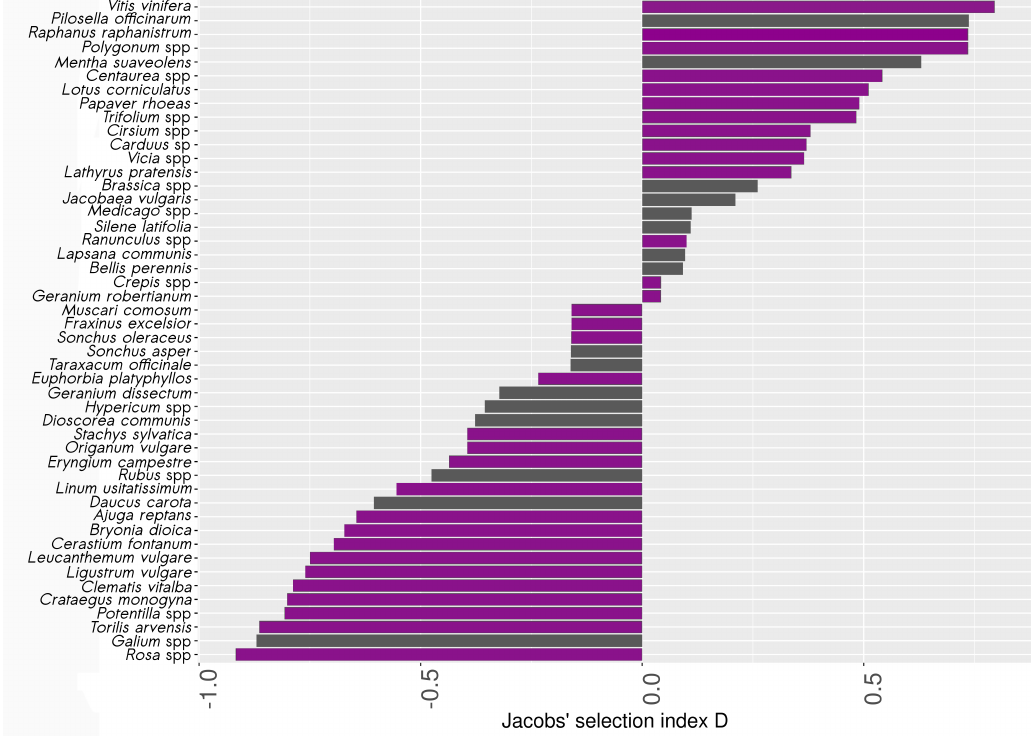
Figure 6. Selectivity of pollen sources by wild bees (Jacobs’ index D). An index > 0 indicates higher relative abundance of the pollen species on bees’ bodies compared to its availability in the botanical survey, whereas an index < 0 indicates negative selection of the species. Purple bars represent species with a significant positive or negative D, following the calculation of the confidence intervals (2.5 and 97.5%) with bootstrap resampling in pollen species, and grey otherwise. For this analysis, some pollen species have been switched at the genus level